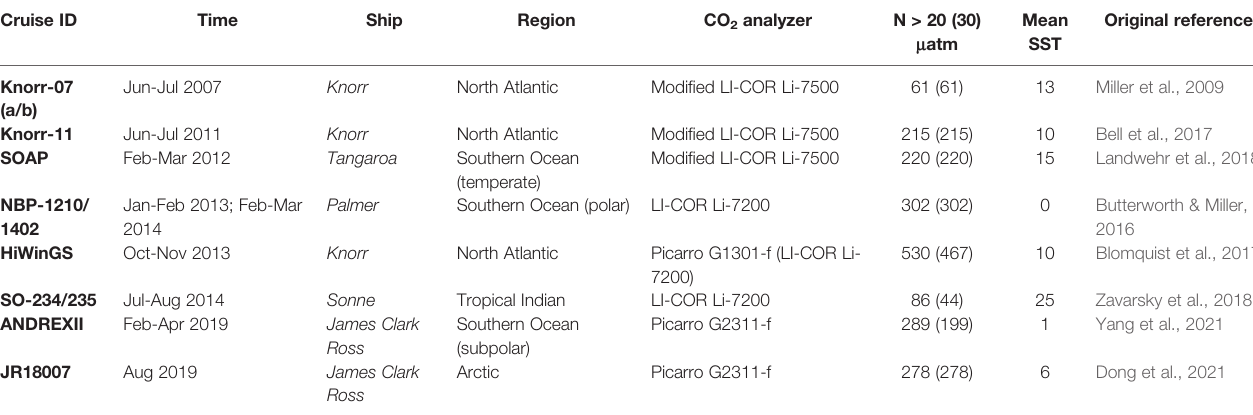
TABLE 1 | Shipboard eddy covariance CO 2 gas transfer measurements using closed-path infrared analyzers (LI-COR Li-7200 or modi fi ed LI-COR Li-7500) or cavity ringdown analyzers (Picarro G1301-f, G2311-f) with a physical